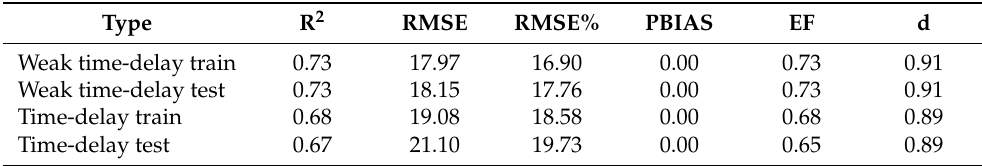
Table 1. Evaluation indicators of weak time-delay data training and time-delay data